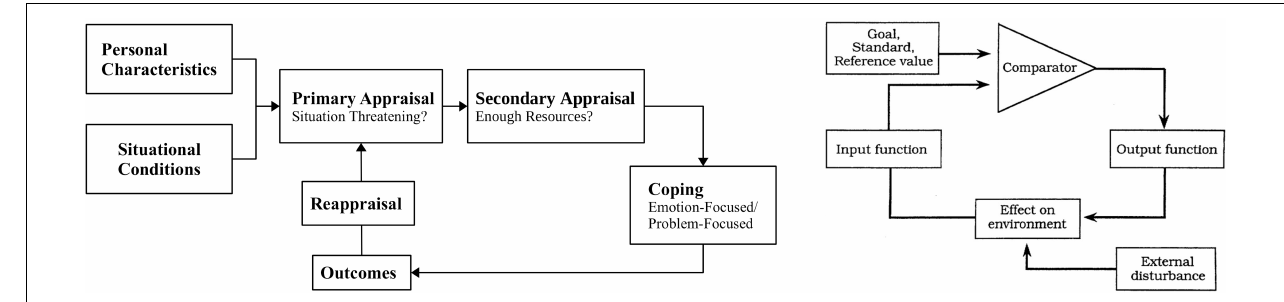
FIGURE 1 | The transactional stress model by Lazarus and Folkman (1984) (left). The feedback-loop model by Carver and Scheier (2002) (right). Copyright 2002 by Sage Pubilcations,